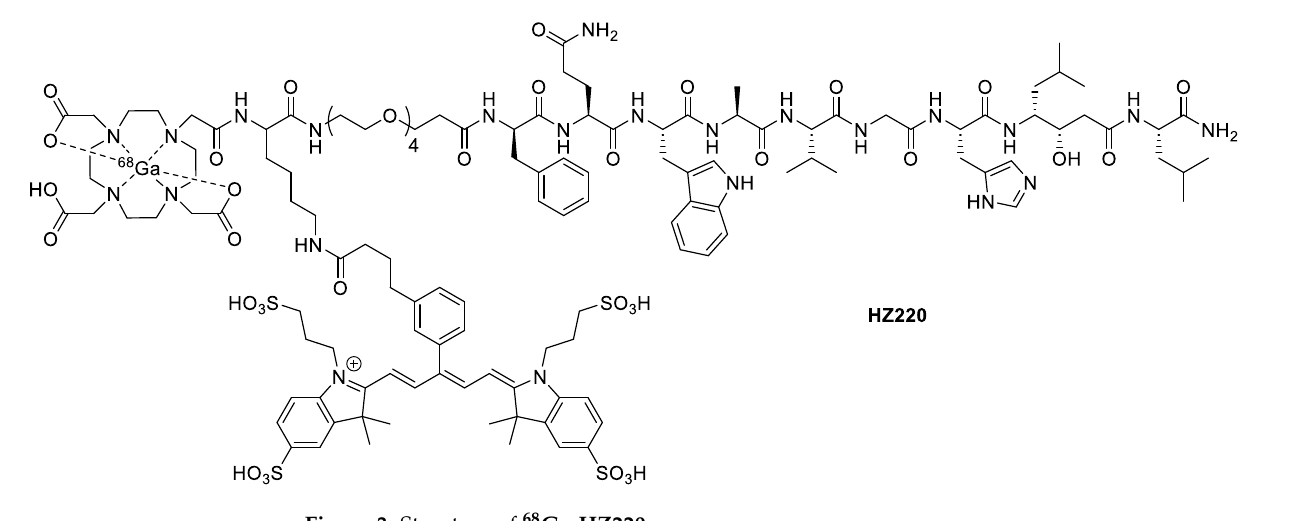
Figure 3. Structure of 68 Ga-HZ220 .